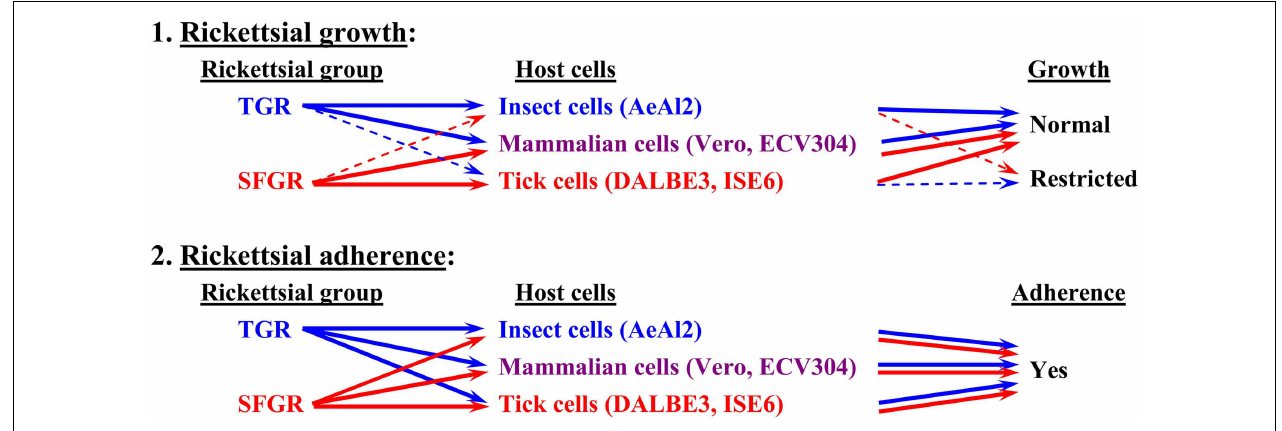
insect cells and that ofTGR was restricted in tick cells. Both groups of pathogenic rickettsiae grew well in mammalian cells. Both groups of rickettsiae were confirmed to be capable of adhering to all of the tested